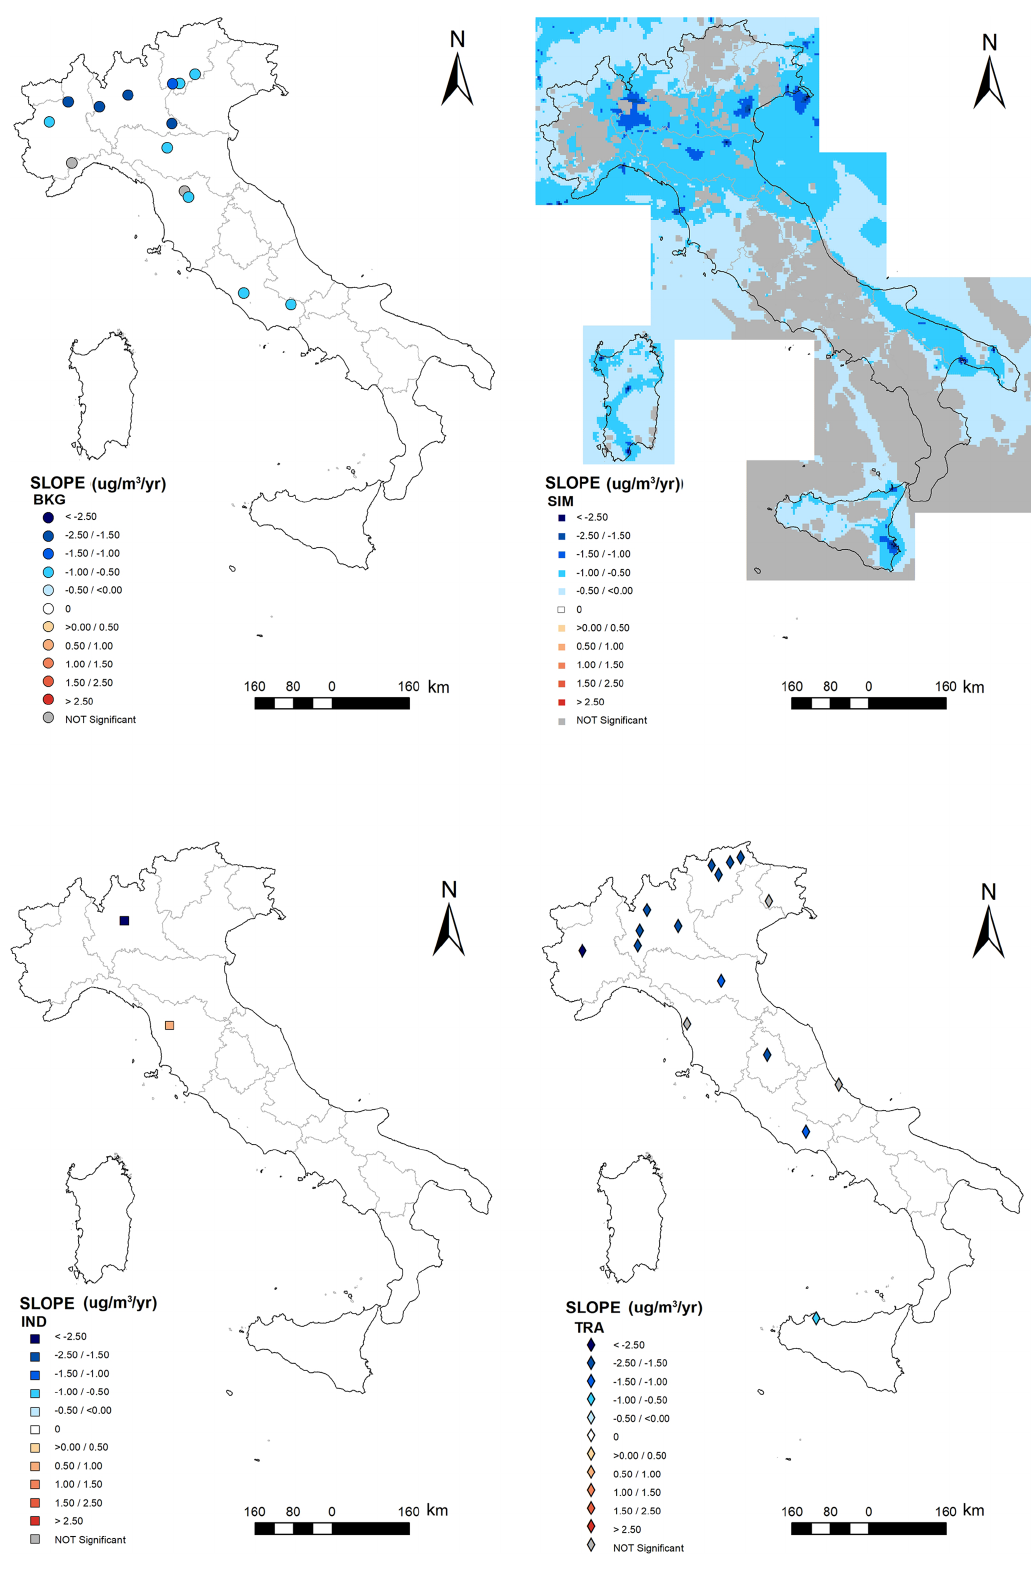
Figure 10. Slopes of PM 10 (µgm − 3 yr − 1 ) observed at background (BKG – upper left panel), industrial (IND – lower left panel), and traffic (TRA – lower right panel) stations and simulated (upper right panel) slopes at each grid point. The grey symbols refer to non-significant trends for both the observations and the simulated